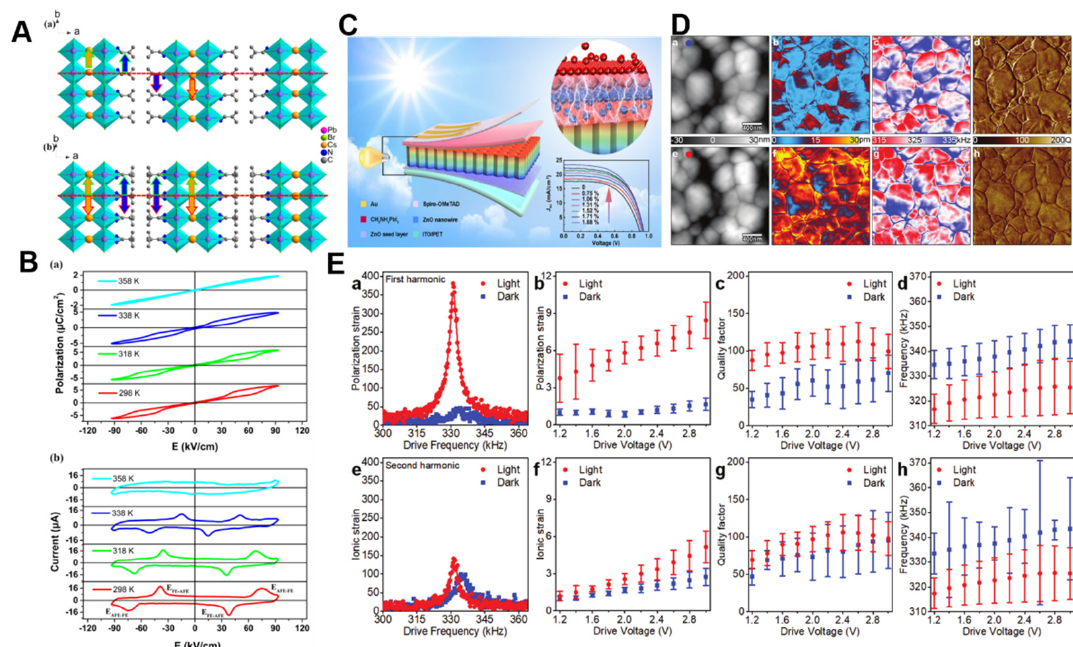
Figure 3. ( A ). The crystal structure comparison of (i-BA) 2 CsPb 2 Br 7 at two different temperatures: ( a ) antiferroelectric phase (293 K) and ( b ) paraelectric phase (360 K). All hydrogen atoms were removed for clarity. ( B ). Antiferroelectric properties and corresponding current signals of (i-BA) 2 CsPb 2 Br 7 : ( a ) the electric polarization as a function of the electric field (P-E) hysteresis loops and ( b ) current versus electric field (I-E) curves for (i-BA) 2 CsPb 2 Br 7 performed at four different tempera- tures (298 K, 318 K, 338 K, 358 K) at 40 Hz. ( C ) Structure of the ZnO-based PSC. Under